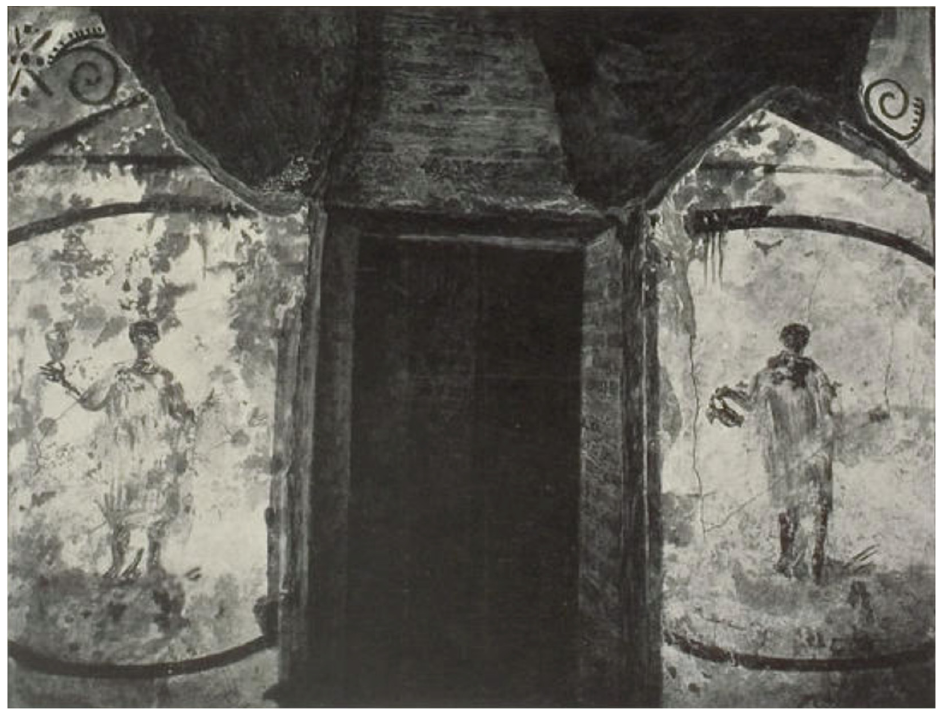
Figure 7. Wall painting depicting servants, second half of 3rd century CE. Rome, Catacombs of Peter and Marcellinus, cubiculum 10, entrance wall. Photo: Wilpert (1903), p. 107.3. Public domain (https://doi.org/10.11588/diglit.1339#0109; downloaded 10 September 2021).